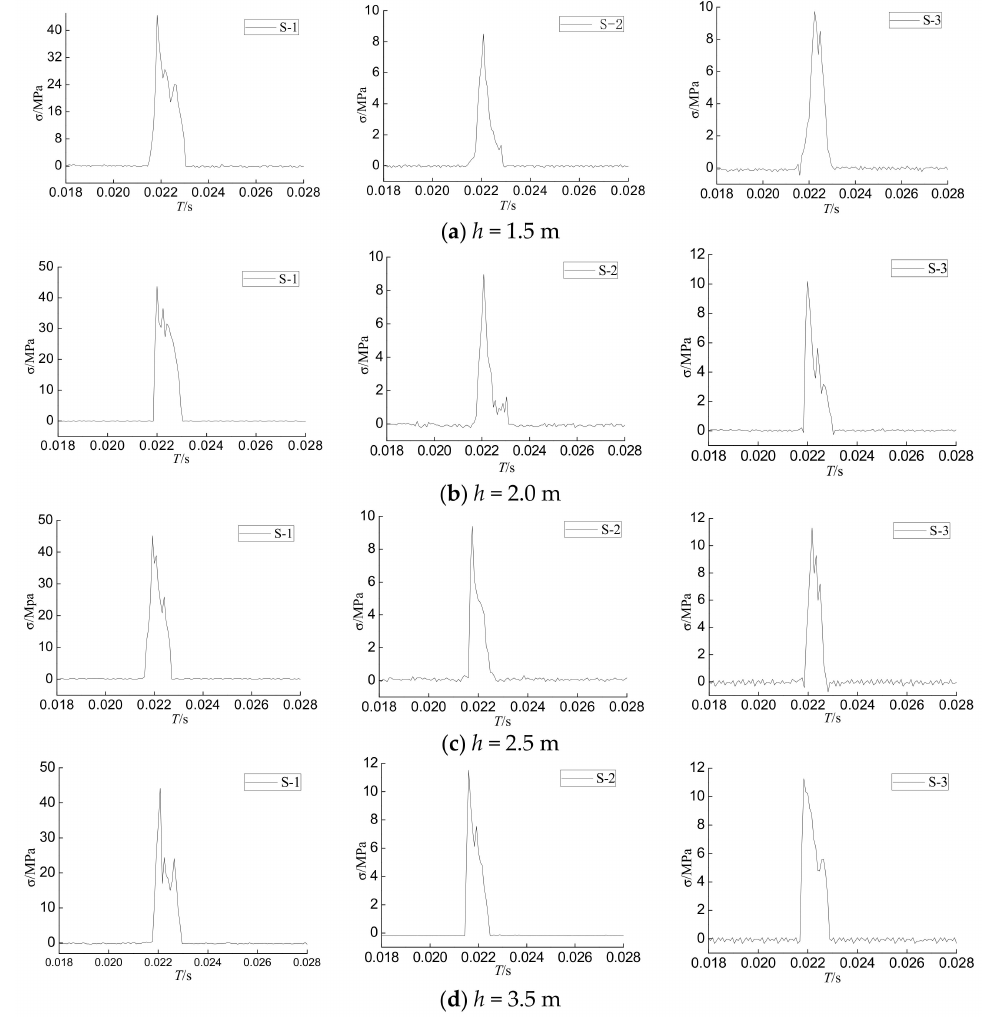
Figure 7. Time history of the internal stresses detected by PVDF sensors.